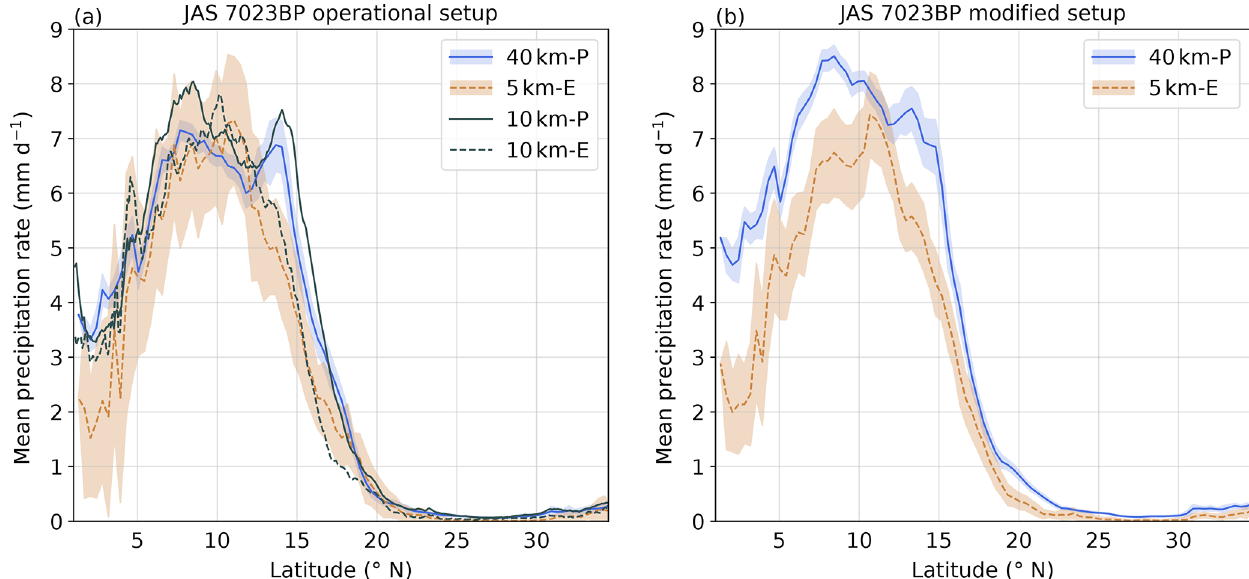
Figure 4. Meridional distribution of monsoonal precipitation for (a) the operational simulations and (b) the setup with modified diurnal cycle (analyzed in Sect. 3.6) for the 40km-P (solid blue), the 5km-E (dashed orange), the 10km-P (solid black) and the 10km-E (dashed black) simulations. The shading displays the daily longitudinal mean standard deviation from the longitudinal mean JAS cycle for the 40km-P and the 5km-E simulation. The longitudinal mean is taken over the land points of the WA domain outlined in Fig. 1.